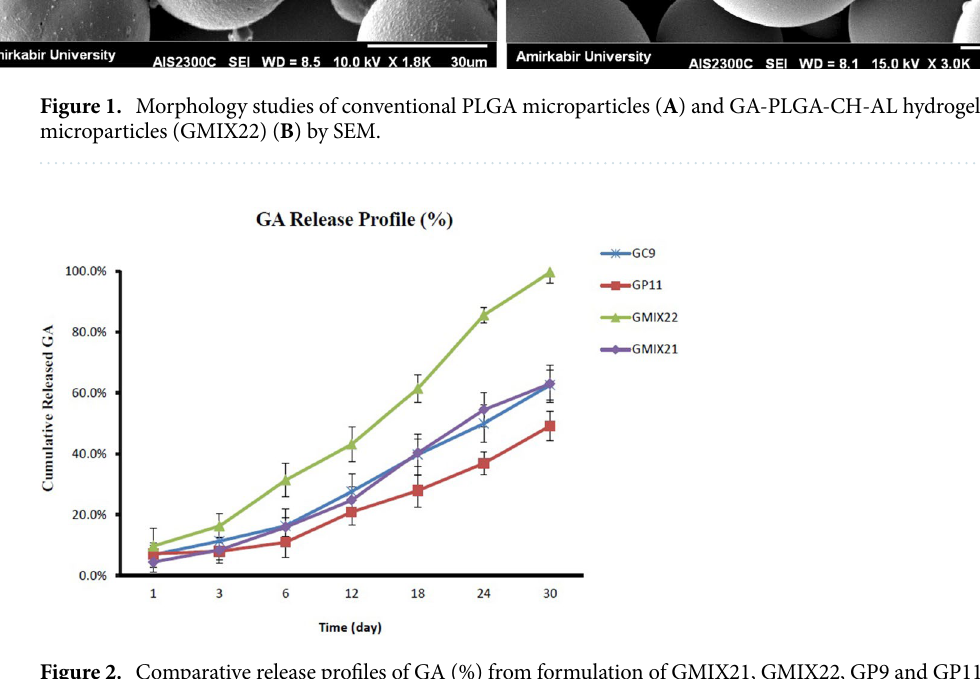
Figure 2. Comparative release profiles of GA (%) from formulation of GMIX21, GMIX22, GP9 and